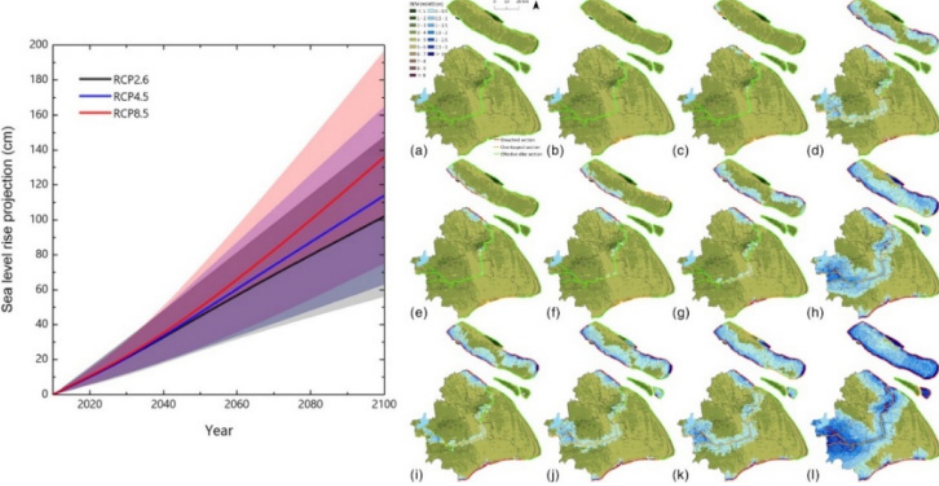
Figure 8. Projected central estimates (50th percentile) of dike failures and flood inundation under present and future scenarios (Representative Concentration Pathways (RCP)) in Shanghai; ( a – d ) are ten-year flood in 2010, 2030, 2050, and 2100; ( e – h ) are one hundred-year flood in 2010, 2030, 2050, and 2100; ( i – l ) are one thousand-year flood in 2010, 2030, 2050, and 2100 (refer to